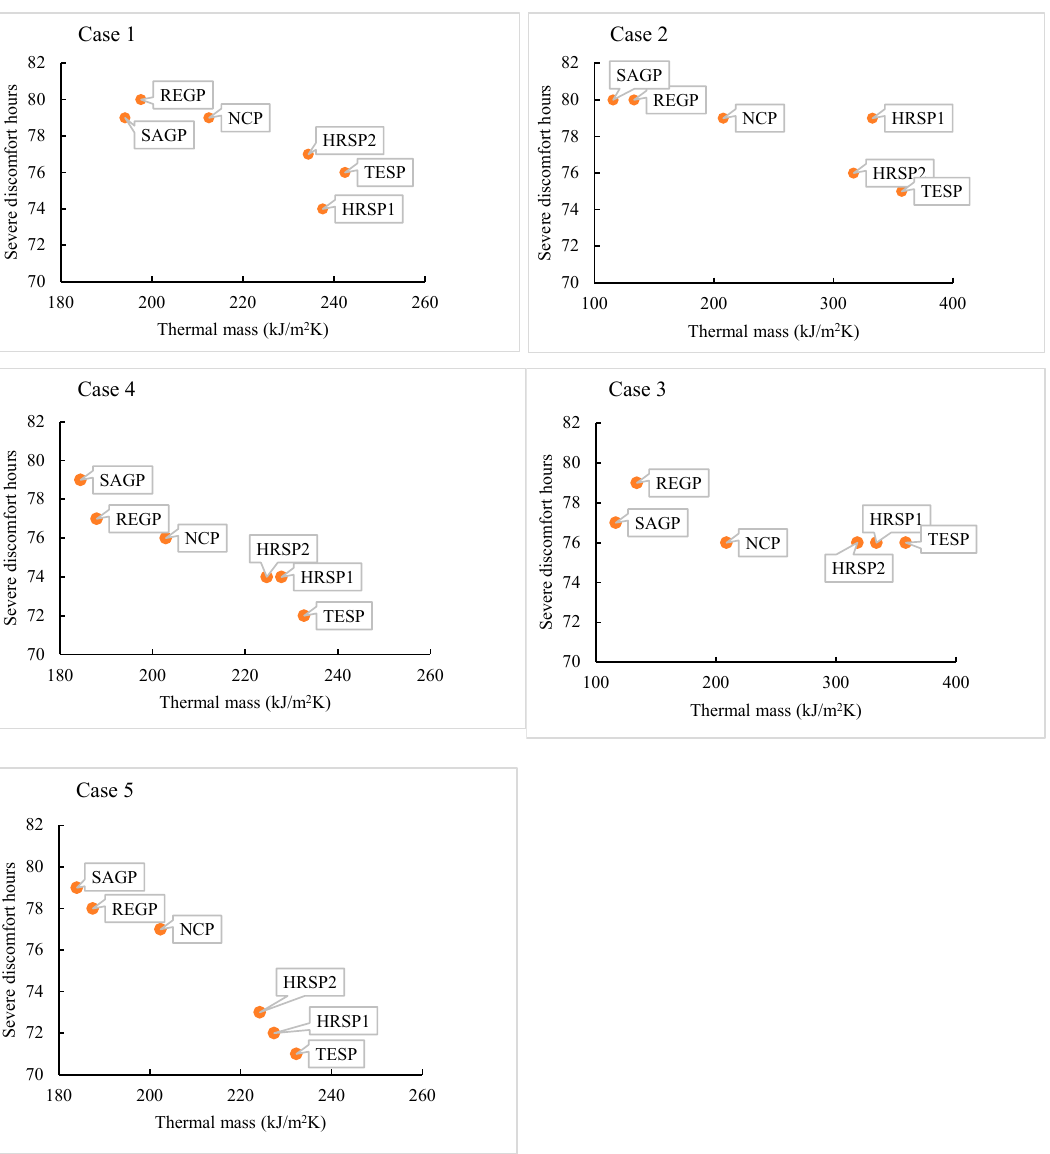
Figure 7. The effect of envelope thermal storage on the number of severe discomfort hours in the living zone.